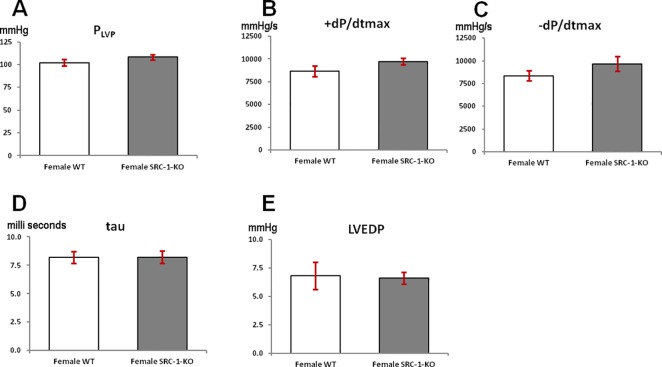
Left ventricular pressure indices.Left ventricular blood pressure parameters of female WT and SRC-1-KO mice. (A) Peak left ventricular pressure (PLVP), (B) Maximal contractiIity (+dP/dtmax), (C) Maximal relaxation (-dP/dtmax), (D) relaxation time constant (tau), and (E) left ventricular end diastolic pressure (LVEDP) obtained from the left ventricular pressure of the mice. Data are presented as mean±SEM (n = 5-7/group); *—p< 0.05. The information supporting this figure is in S2 Dataset.